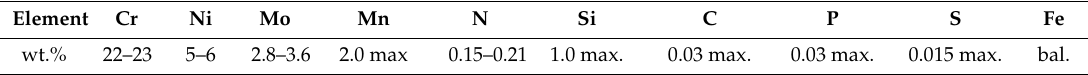
Table 1. Chemical composition of the used SAF 2205 powder